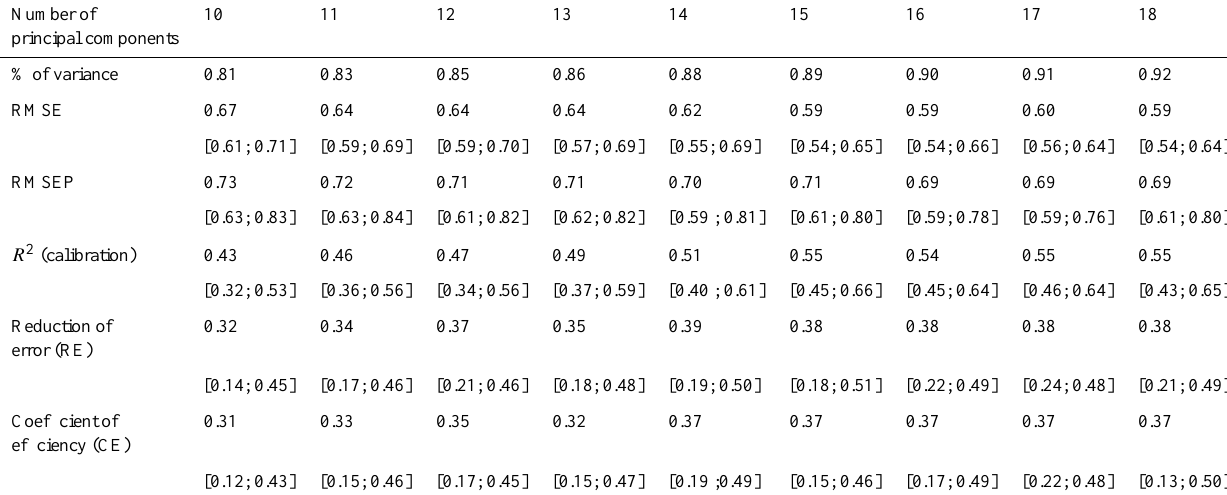
Table 4. Statistics of reconstructions of June to August temperature in the Alps functions of the number (10–18) of principal components used. Four neurons and a maximum of 5000 iterations were used in each reconstruction. Calibration statistics are computed on the randomly selected observations within the 1818–2003 period. Validation statistics are based on not taken observation within the same period. The RMSE and the R 2 statistic tests the quality of fit on the calibration data, while the RMSEP, RE and CE test the prediction capacity of the transfer function by using independent